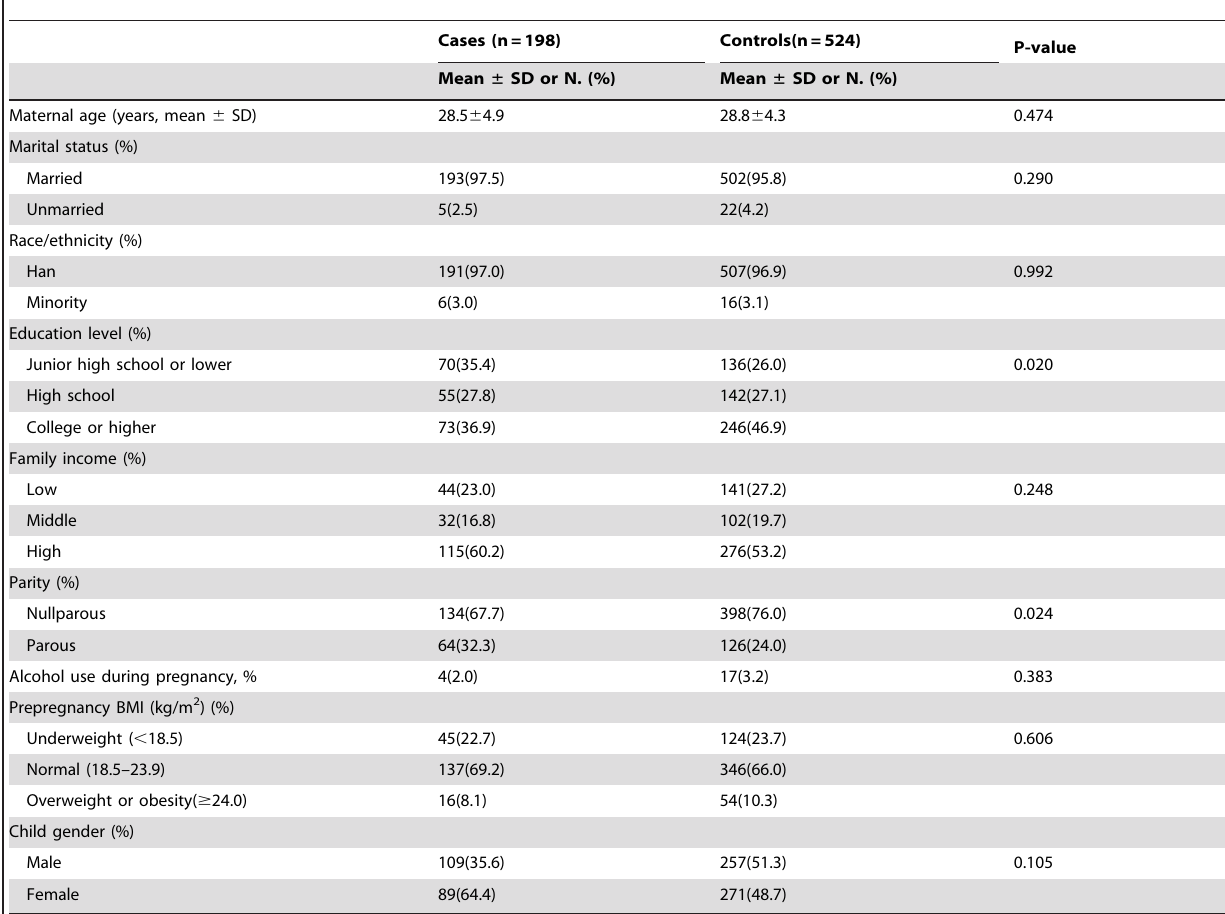
Table 1. Comparison of characteristics between spontaneous PTD cases and